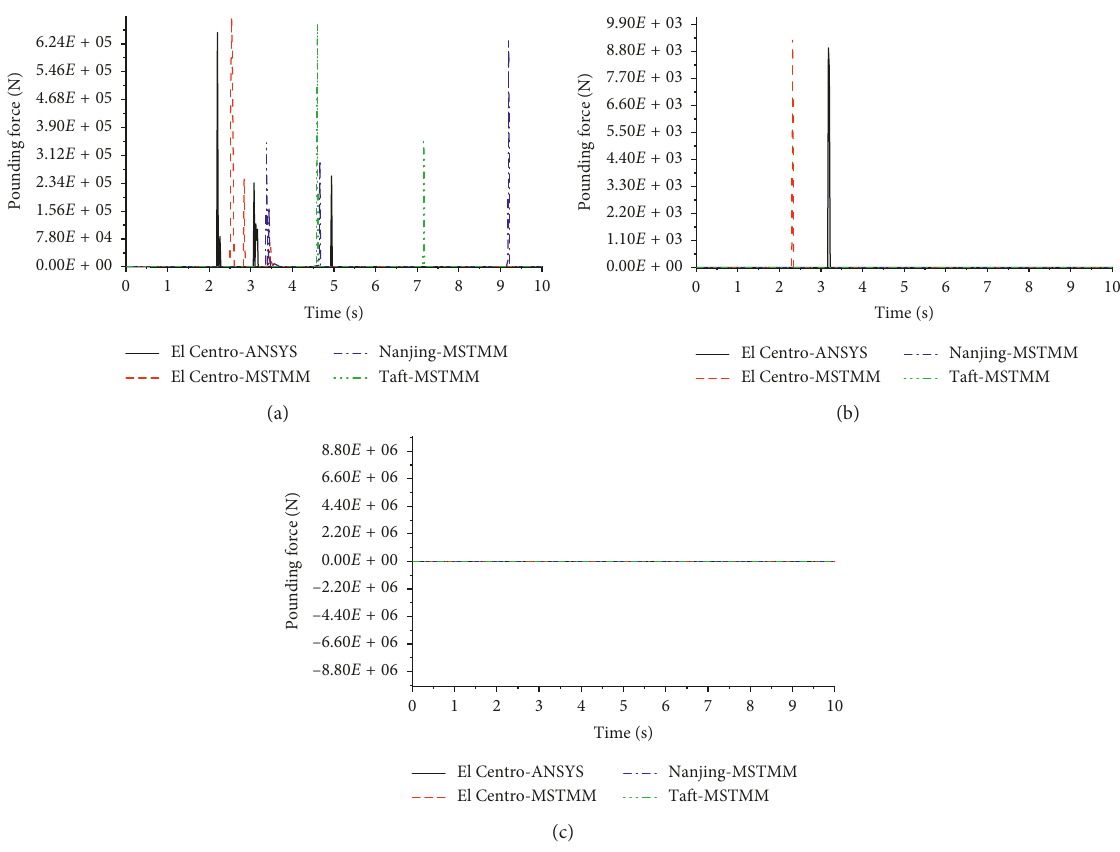
Figure 14: Time-history diagram of J (b) 200mm, and (c) 220 mm. Seismic peak